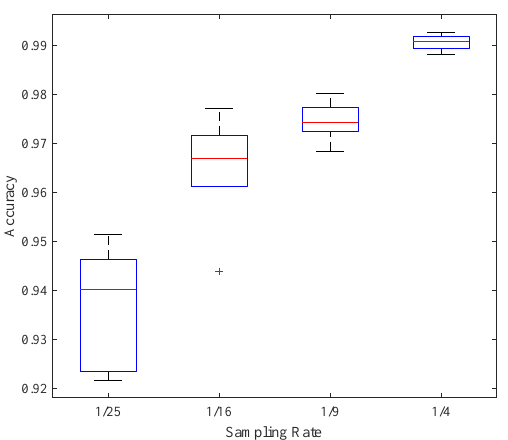
Figure 7. Classification accuracy vs different sampling rates for five runs.